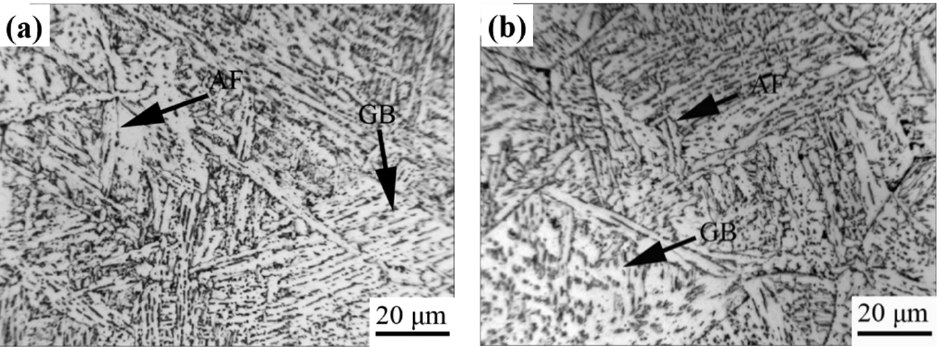
Figure 2. Optical structure of simulated CGHAZ with a heat input of 20 kJ/cm in the steel samples containing different amounts of. ( a ) 0.073%, ( b ) 0.110%. Table 3. Measured austensite grain size in simulated CGHAZ.